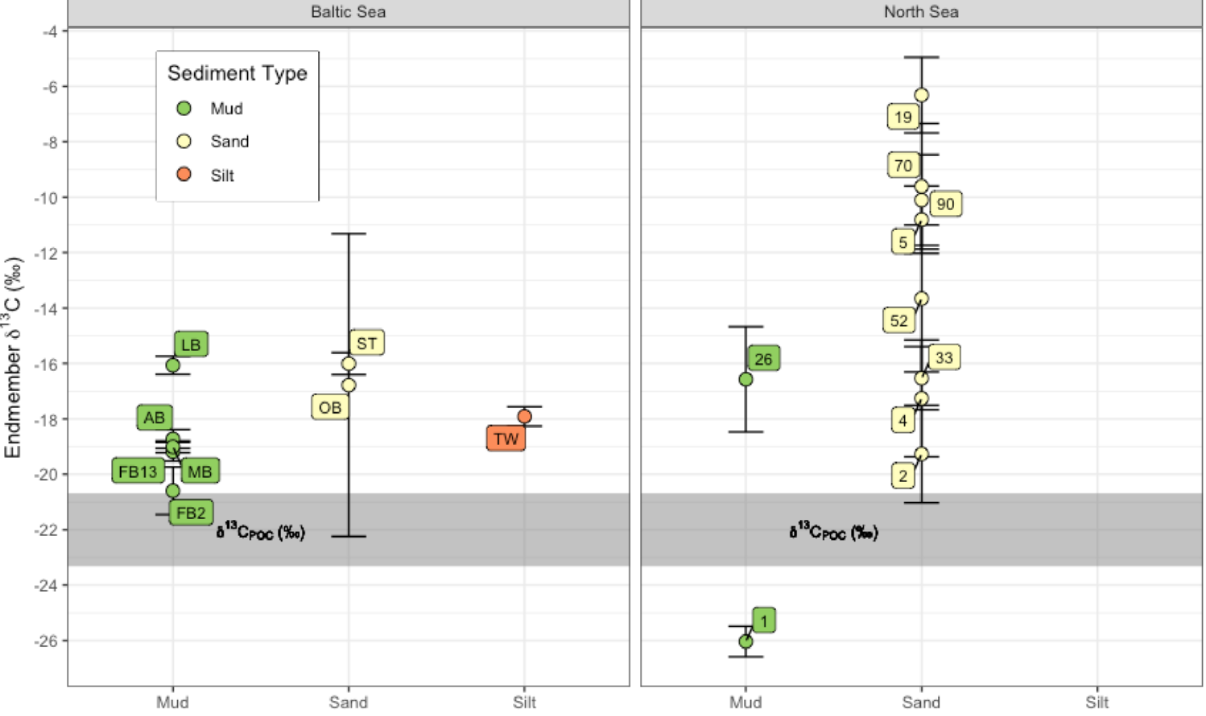
Figure 5. Potential endmember isotopic values for porewater DIC, derived from Miller–Tans plots of DIC × δ 13 C-DIC vs. DIC (shown in Fig. S1 in the Supplement). The grey area represents a range in expected δ 13 C-POC values for the North and Baltic seas combined, and the error bars represent the standard error of the Miller–Tans